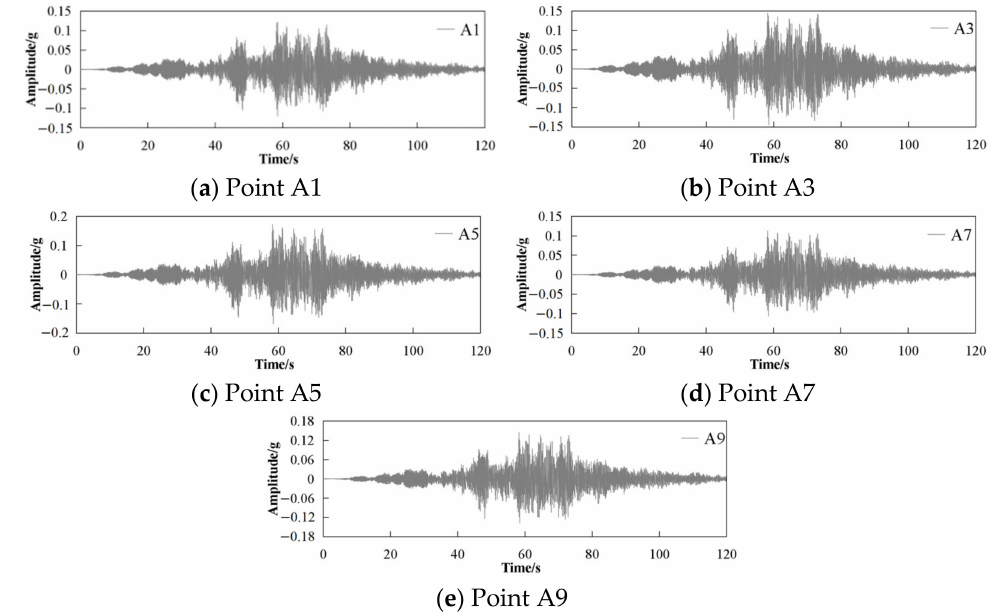
Figure 8. Acceleration time history of measuring points at the slope surface: ( a ) A1, ( b ) A3, ( c ) A5, ( d ) A7, ( e )